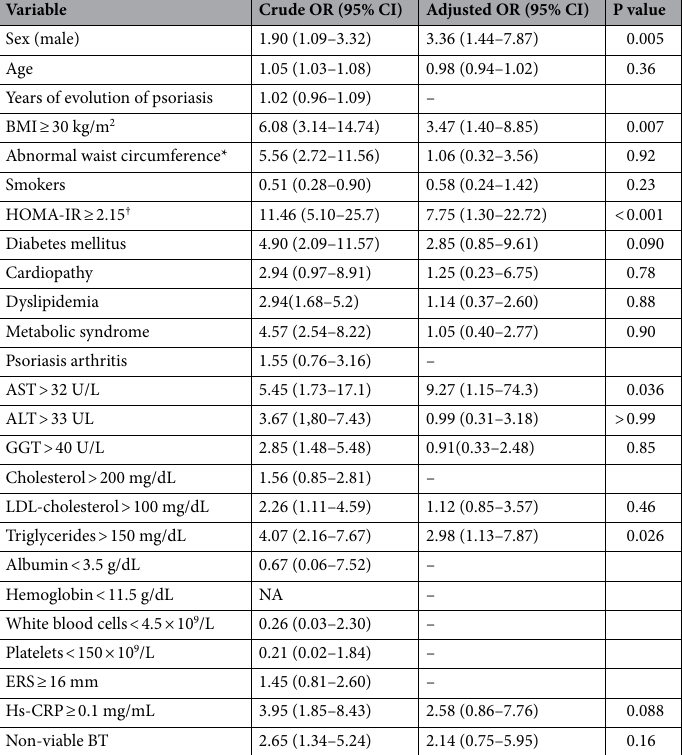
Table 2. Risk of developing non-alcoholic fatty liver disease (NAFLD), according to explanatory variables (bivariable and multivariable analysis). AST aspartate aminotransferase, ALT alanine aminotransferase, BMI body mass index, BT bacterial translocation, CI confidence interval, ERS erythrocyte sedimentation rate, GGT g-glutamyl transferase, hs-CPR high-sensitivity C-reactive-protein, HOMA-IR homeostatic model assessment of insulin resistance, LDL low-density lipoprotein, NA not available, OR odds ratio. *Abnormal waist circumference: women, ≥ 86 cm, ≥ 95 cm male. † HOMA-IR available in 211